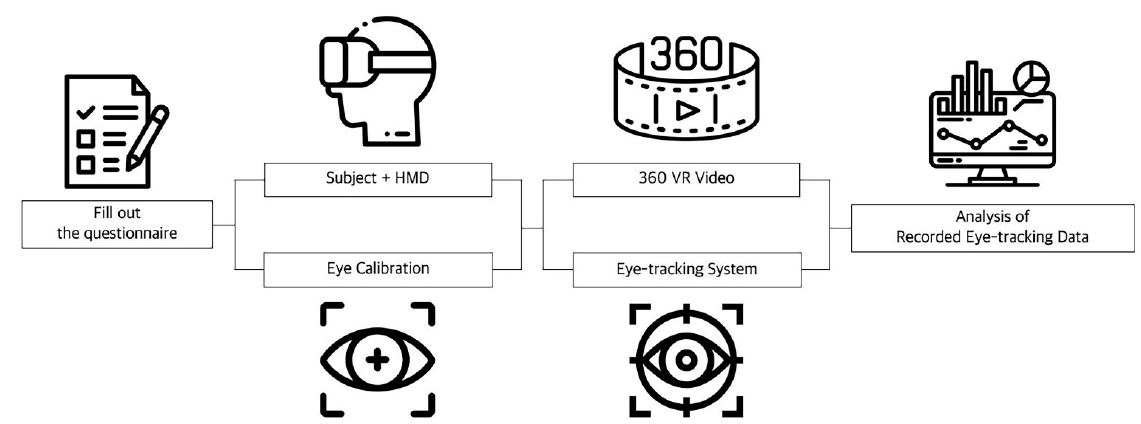
Figure 14. The 360-degree VR eye-tracking system structure.